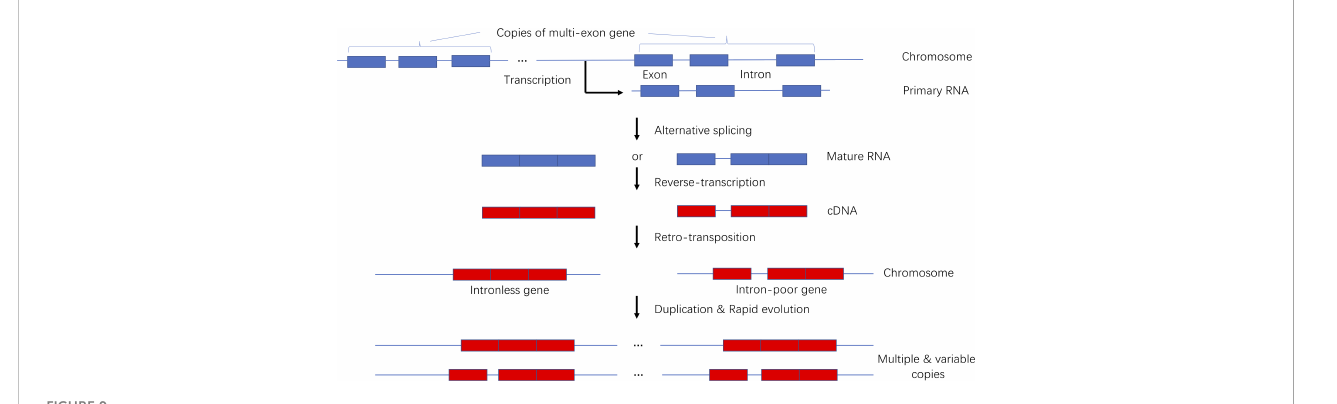
FIGURE 9 Model of the origin and evolution of intronless and intron-poor